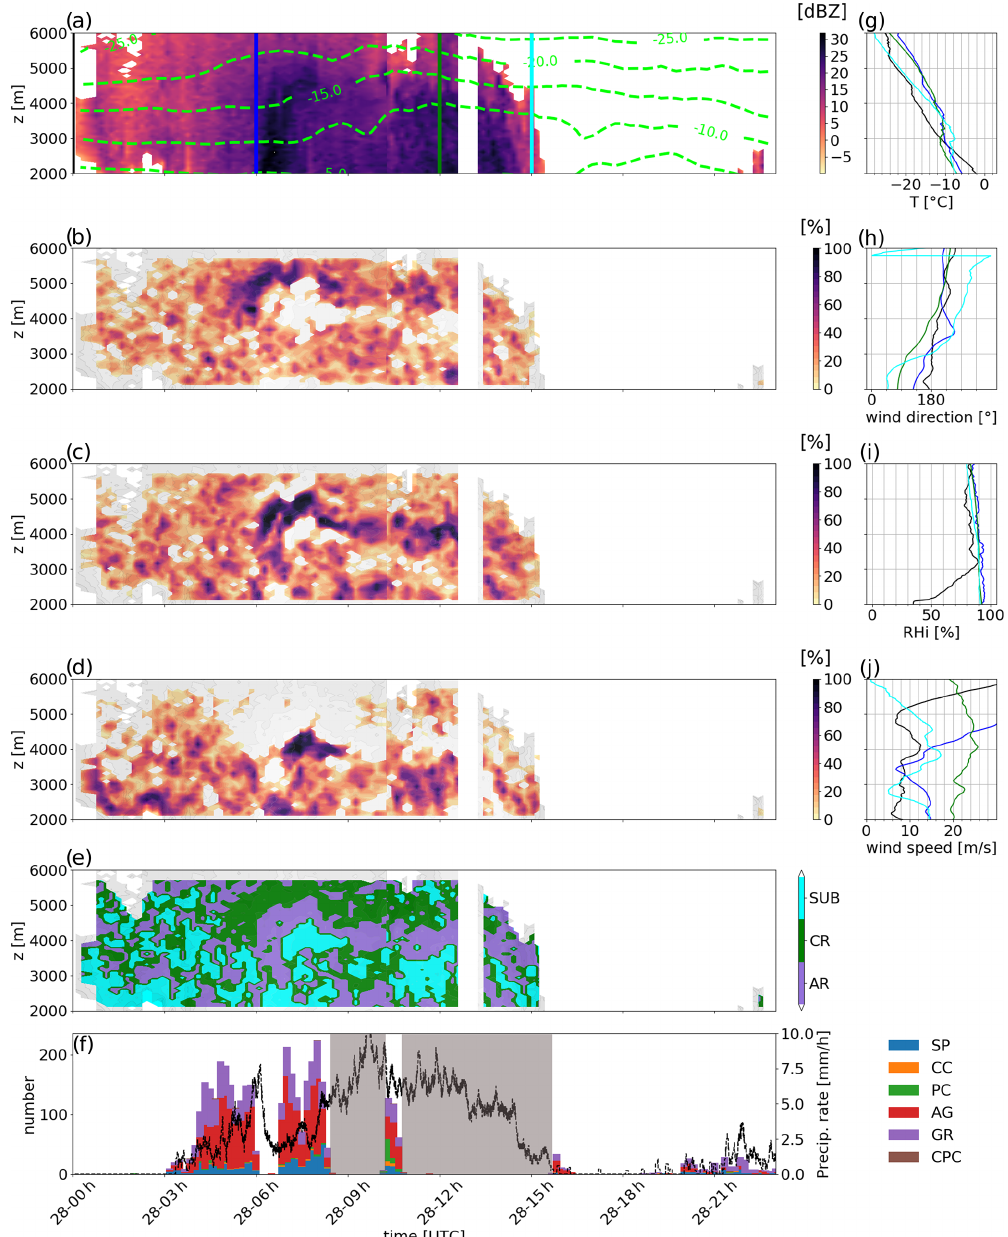
Figure 4. Same as Fig. 3 for EV2 without the colored boxes. The gray areas in (f) mask periods during which the MASC was not